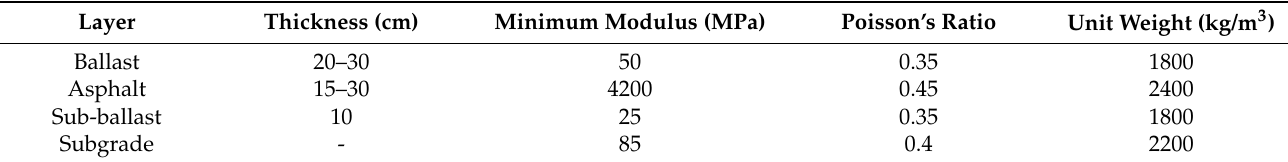
Table 2. Properties of a typical track with asphalt underlayment used in the USA [20,21].